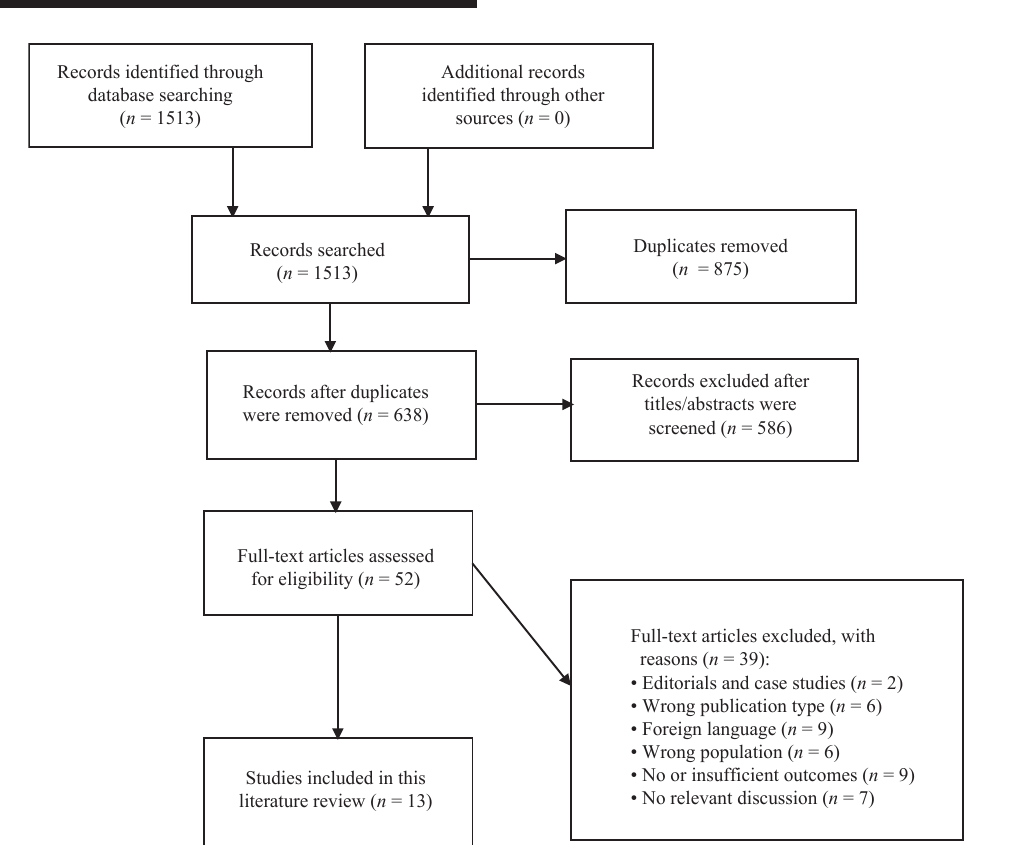
Figure 1. Literature search